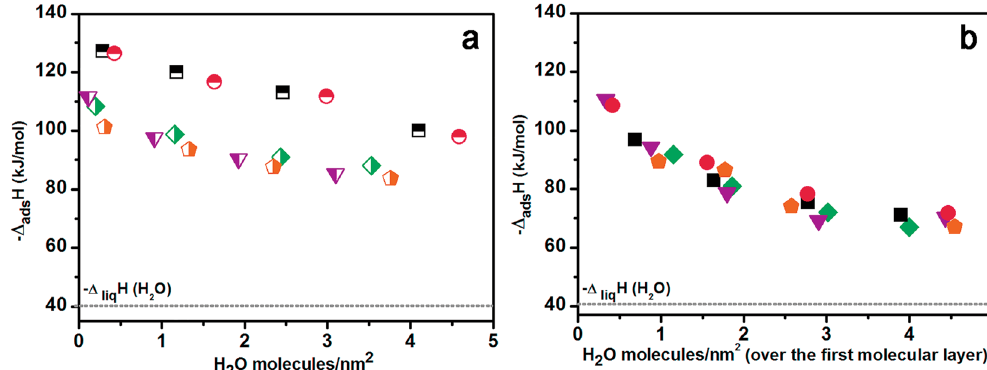
Figure 4. Enthalpy of adsorption versus uptake of H 2 O molecules on: red symbols = HA1; black symbols = HA2; orange symbols = Cit–HA–4 h; purple symbols = Cit–HA–24 h and green symbols = Cit– HA–96 h. Panel a, half-filled symbols: attainment of the first hydration layer. Panel b, full symbols: additional adsorption of water, within the limit of the method. Related volumetric isotherms (adsorbed H 2 O molecules·nm 2 vs . pH 2 O) are in Supplementary Fig. S5. The dotted line indicated the value of latent enthalpy of liquefaction of water, −Δ liq H(H 2 O), for the sake of